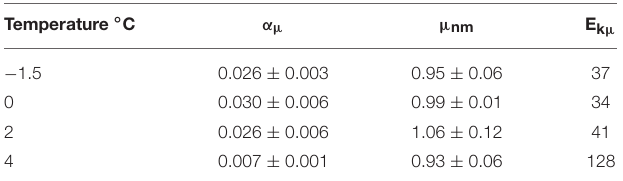
TABLE 3 | Growth fitting parameters of Phaeocystis grown between − 1.5 and 4 ◦ C. Temperature ◦